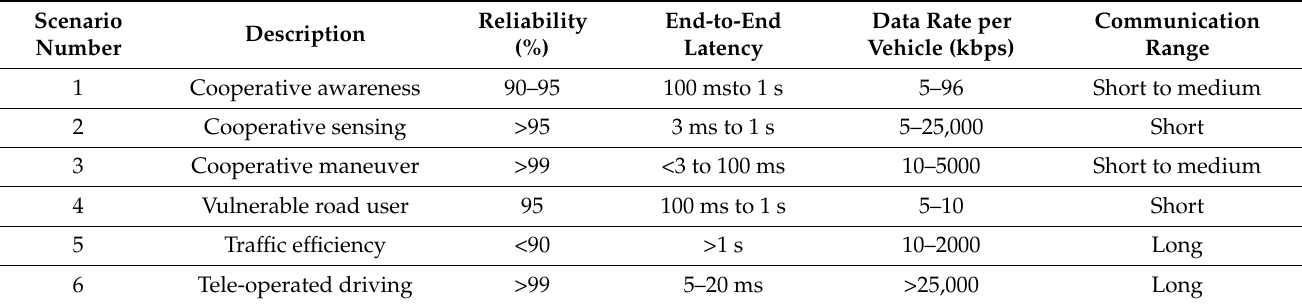
Table 1. 3GPP 5G V2X